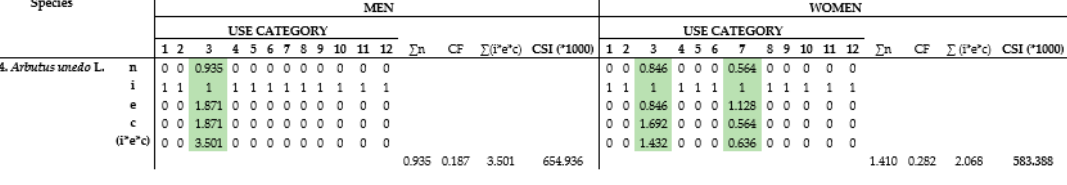
Figure 2. Excel spreadsheet model to introduce row data from paper cards.